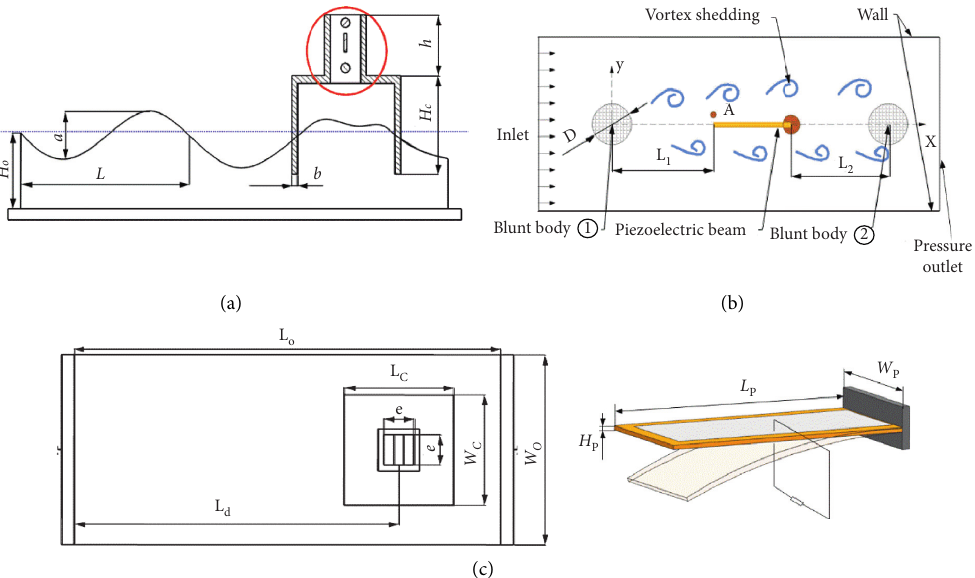
Figure 2: The structure of the piezoelectric wave energy harvester. (a) OWC piezoelectric generator in the water flume as shown with the front and planform view, (b) the vortex shedding in the channel, and (c) piezoelectric cantilever